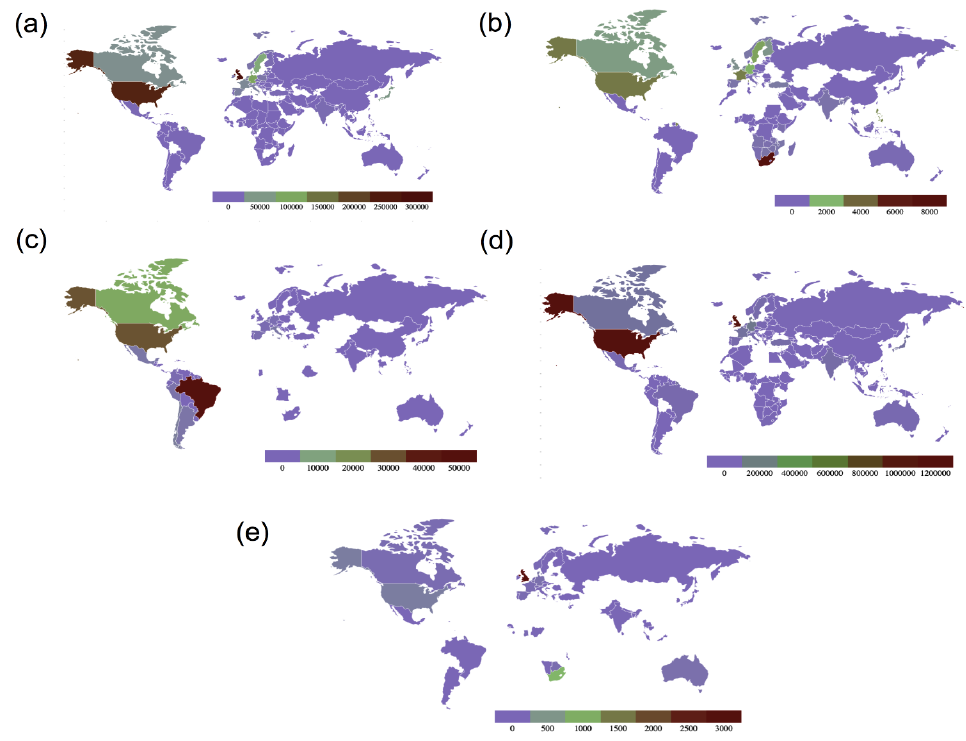
Figure 5. Maps showing global country-wise sequence count of all variants of concern as of 13 September 2021. ( a ) Sequence count of B.1.1.7 (Alpha variant), ( b ) sequence count of B.1.351 (Beta variant), ( c ) sequence count of P.1 (Gamma variant), ( d ) Sequence count of B.1.617.2 (Delta variant) and ( e ) sequence count of B.1.1.529 (Omicron variant) (data source: GISAID, Figure redrawn using GeoMaps). Table 1. SARS-CoV-2 variants of concern (VOCs) with their date and place of emergence and im- portant spike mutations, along with their effect on the variant’s overall transmissibility. WHO